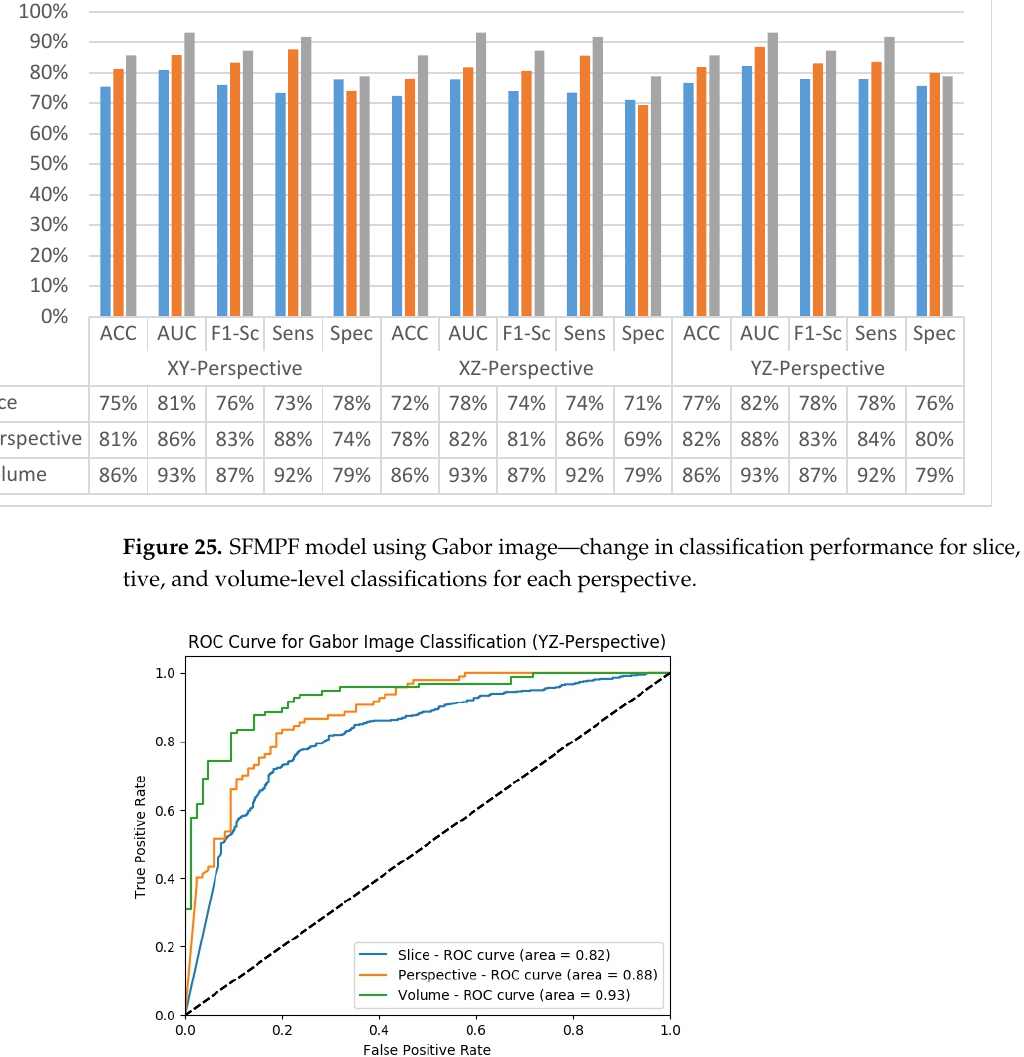
Figure 26. SFMPF model using Gabor image—comparison of ROC curve for slice, perspective, and volume-level classifications for the slices from YZ-perspective.